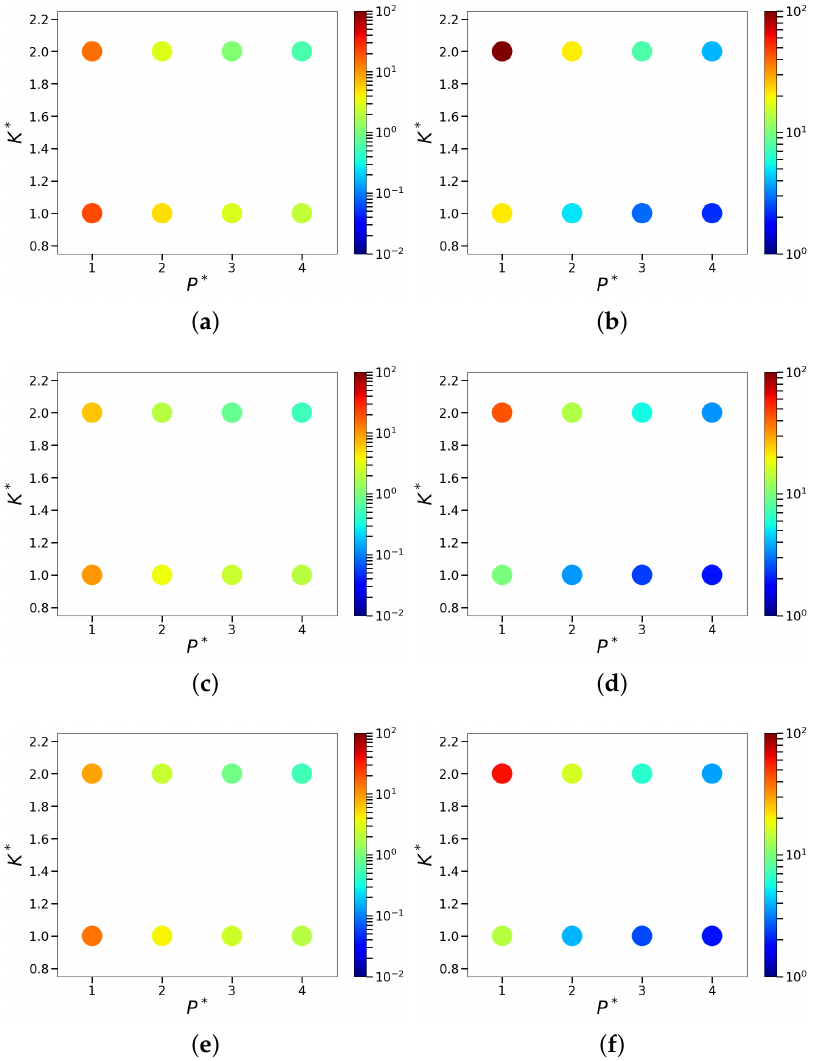
Figure A7. Isocontours of the normalized mean squared ( l 2 ) ELM-based sparse reconstruction errors of Re = 800 case for maximum, minimum, and average error using different choices for random sensor placement. Left: normalized absolute error metric, (cid:101) 1 . Right: normalized relative error metric, (cid:101) 2 . ( a ) (cid:101) 1 (maximum); ( b ) (cid:101) 2 (maximum); ( c ) (cid:101) 1 (minimum); ( d ) (cid:101) 2 (minimum); ( e ) (cid:101) 1 (average); and ( f ) (cid:101) 2